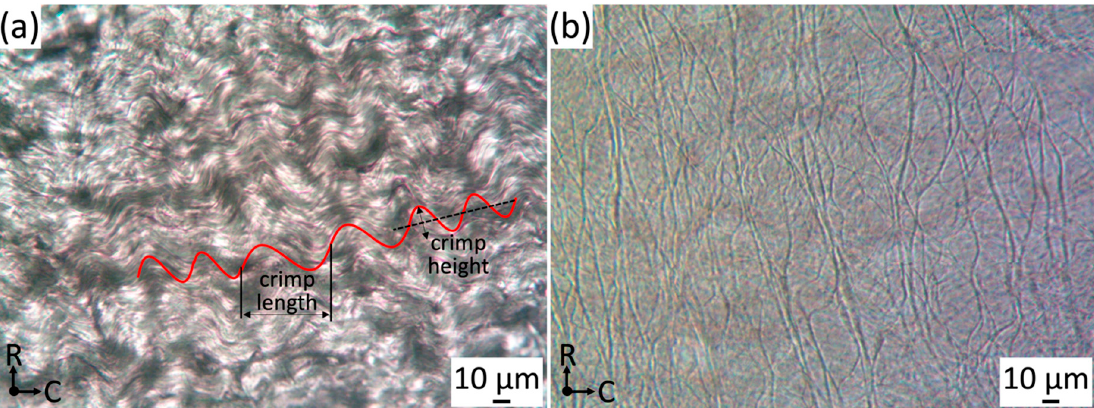
Figure 2. ( a ) Collagen crimp light microscopy images focused on the parietal side of jugular venous valve tissue (400×), where C = circumferential and R = radial directions. ( b ) Light microscopy of isolated elastin microstructure (luminal side) (400×). Please note that it was a projected image since several different focus levels were included in the image.